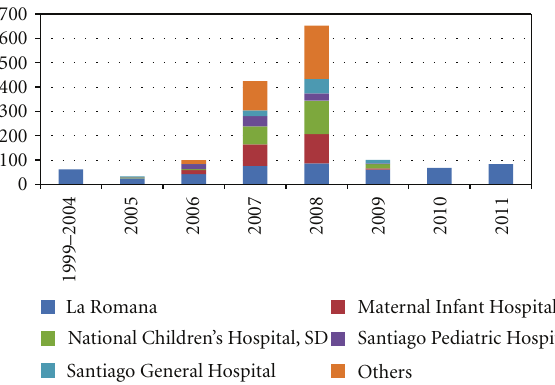
Figure 1: Perinatally HIV-Exposed Infants, by 34 Reporting centers, Dominican Republic, 1999–2011 “La Romana”: nongovernmental organization (NGO) located in La Romana, in southeastern Dominican Republic, provides prenatal care to 81–101 pregnant women living with HIV annually, approximately 30% of